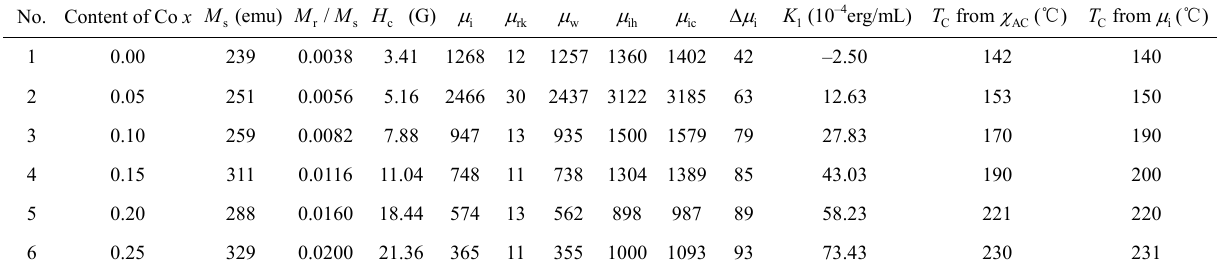
Table 3 Data on magnetic parameters like saturation magnetization ( M s ), M r / M s , coercivity ( H c ), initial permeability (  i ), rotational permeability (  rk ), wall permeability (  w ), magneto crystalline anisotropy constant ( K 1 ), thermal hysteresis of initial permeability, Curie temperature ( T C ) from  AC and  i for all the ferrites No. Content of Co